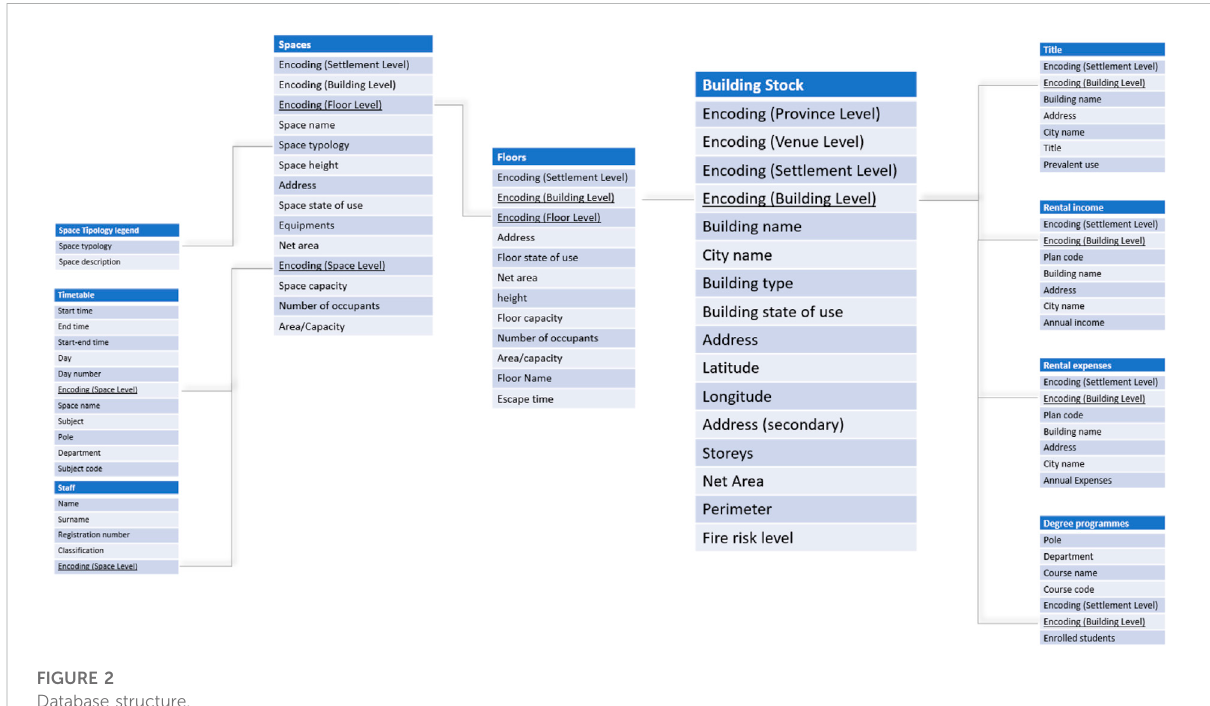
FIGURE 2 Database